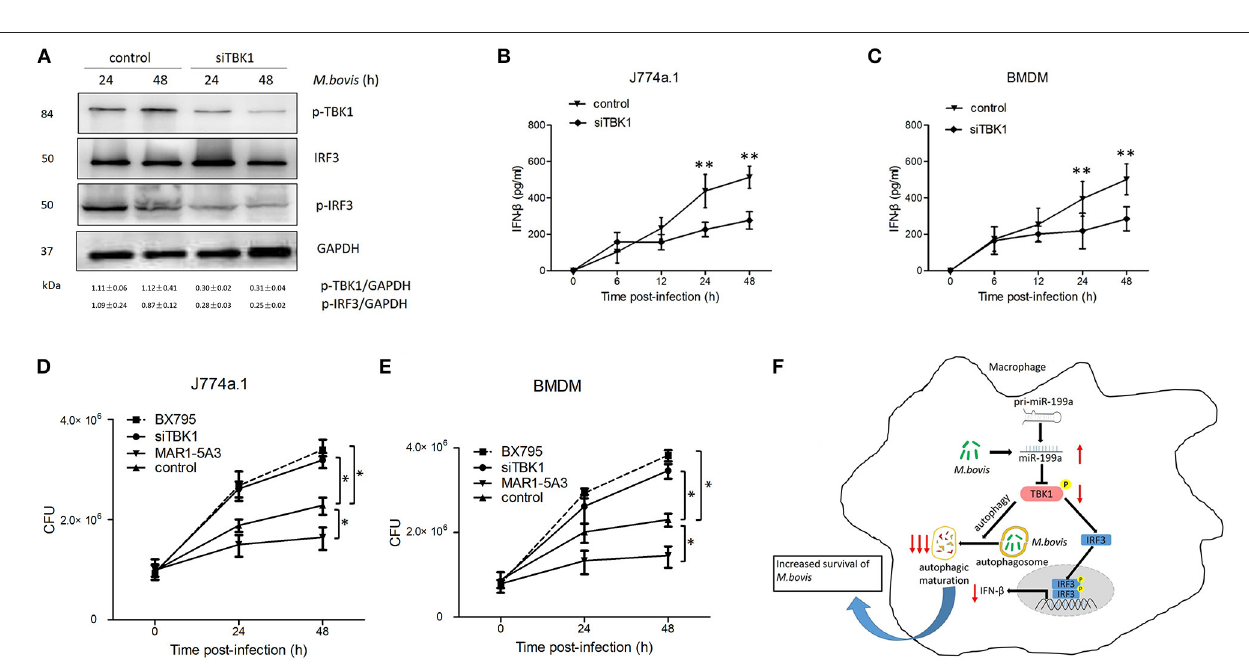
FIGURE 6 | TANK-binding kinase 1 (TBK1) attenuates Mycobacterium bovis ( M. bovis ) survival in vitro by control of autophagy and the production of interferon- β (IFN- β ). (A) J774a.1 cells were treated with control or siTBK1 for 24h and then infected with Mycobacterium bovis ( M. bovis ) at a multiplicity of infection (MOI) of 10 for 24 or 48h. Quantitative analysis of the phosphorylated TBK1 (p-TBK1), IRF3 and phosphorylated IRF3 (p-IRF3) bands normalized to GAPDH is shown. (B) J774a.1 cells and (C) mouse bone marrow monocyte-derived macrophages (BMDMs) were treated with control or siTBK1 for 24h, followed by M. bovis infection at a MOI of 10 for the indicated time. Production of IFN- β was measured by ELISA assay. (D) J774a.1 cells and (E) mouse bone marrow monocyte-derived macrophages (BMDMs) were treated with control, siTBK1 for 24h, BX795 (5 µ M, 2h) and IFNAR1-blocking monoclonal antibody MAR1-5A3 (1 µ g/ml, 2h), and then infected with Mycobacterium bovis ( M. bovis ) at a multiplicity of infection (MOI) of 10 for 24 or 48h. M. bovis survival was analyzed by colony-forming units (CFU). (F) Model depicting the cascade of events following M. bovis infection involving sequential upregulation of miR-199a; downregulation of TBK1; suppression of autophagosomes maturation; downregulation of IFN- β and increased survival of M. bovis . The red arrows show an inhibition of TBK1 by miR-199a seems high importance for the abrogation of autophagy than down regulation of IFN- β via TBK1/IRF3 axis. Data is presented as mean ± SD in three independent experiments (* P < 0.05; ** P < 0.01).